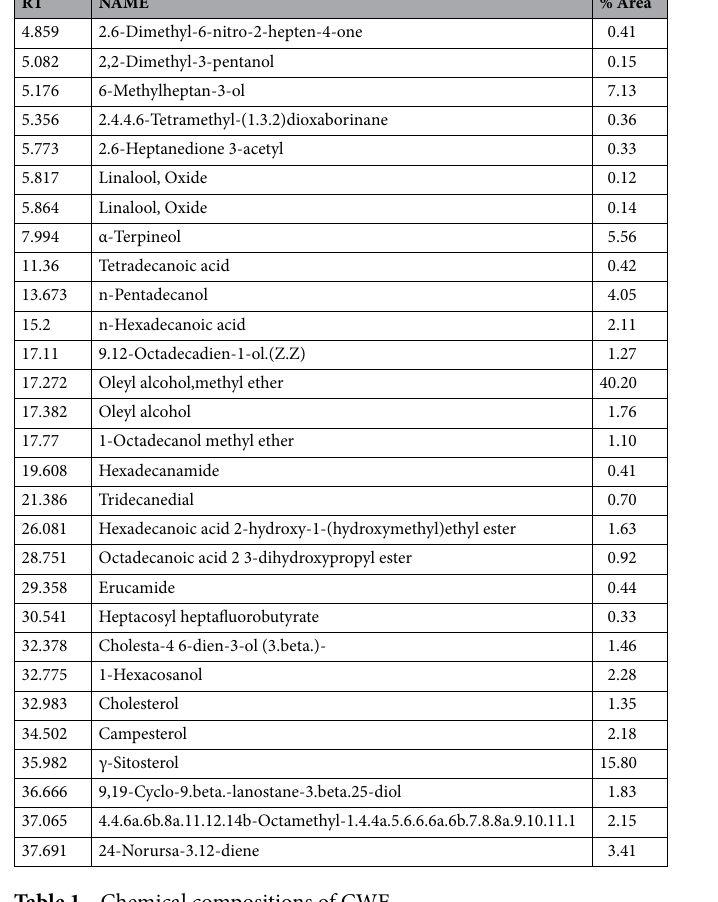
Table 1. Chemical compositions of